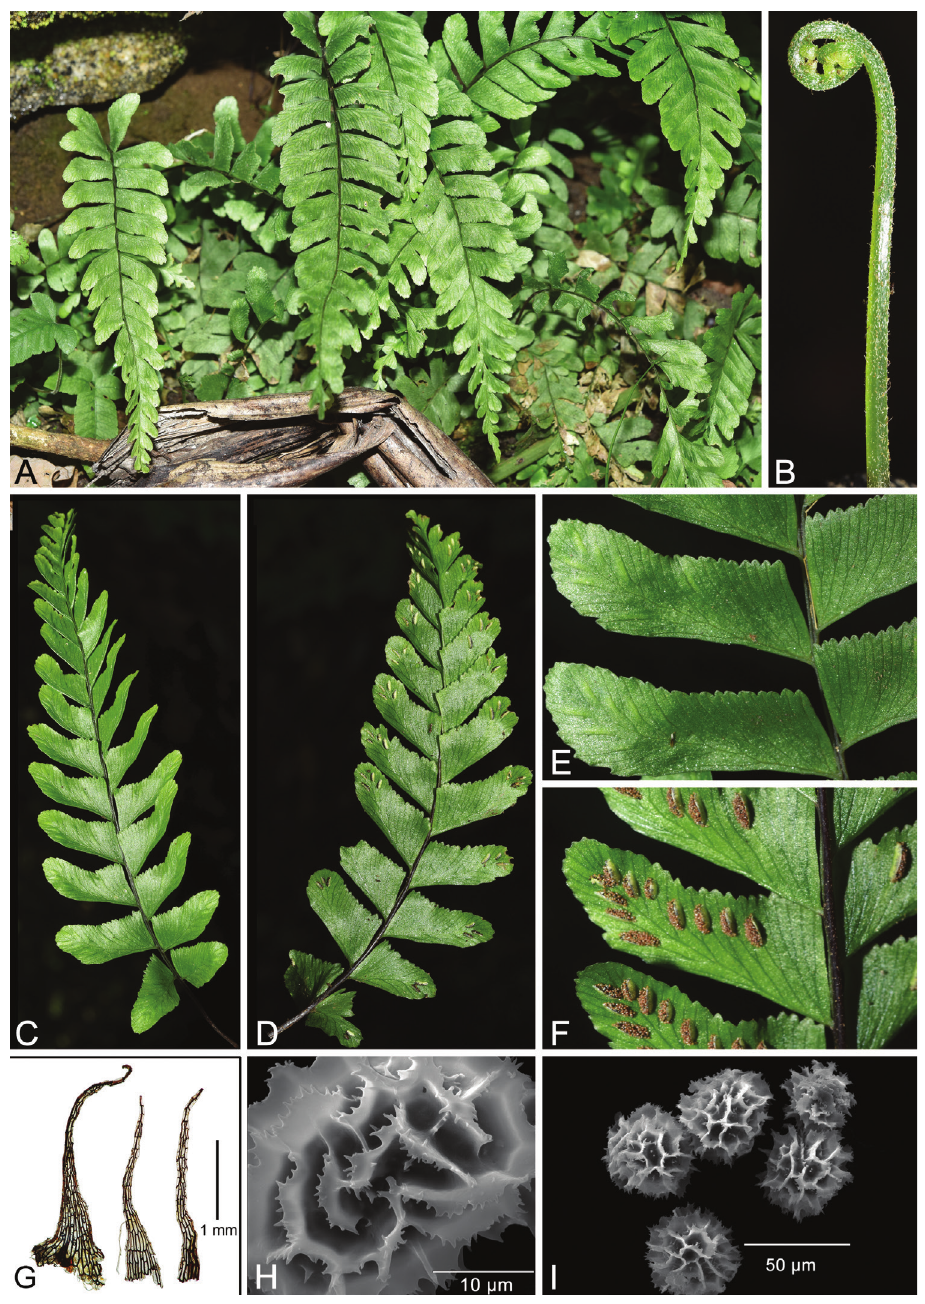
Figure 1. Hymenasplenium tholiformis sp. nov. A habit B crozier C adaxial lamina D abaxial lamina E adaxial pinnae F abaxial pinnae, showing sori G rhizome scales H spore surface I spores. Photos credit: A–F by L. Zhang; G–I by W.-Z. Ma & Y.-L.